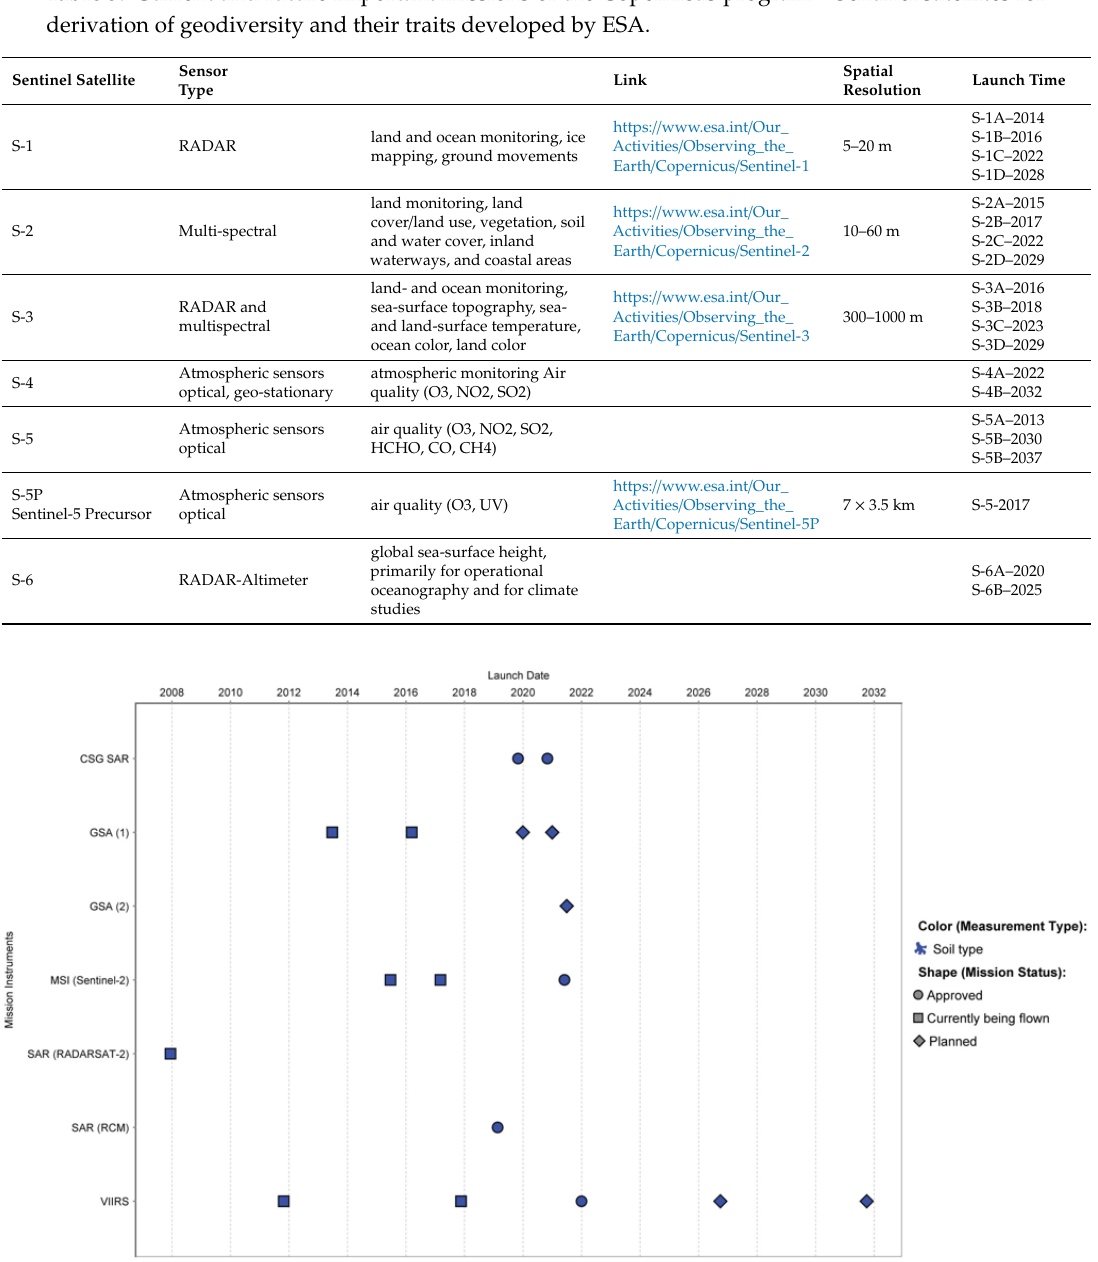
Figure 6. Current and future RS missions and RS satellites for monitoring soil characteristics with information about the mission status, extracted from the CEOS database (Committee on Earth Observation Satellites) [205]. Table 4 gives a selection of RS-aided data products of soil characteristics. Table 4. Selection of RS-aided data products of soil characteristics.